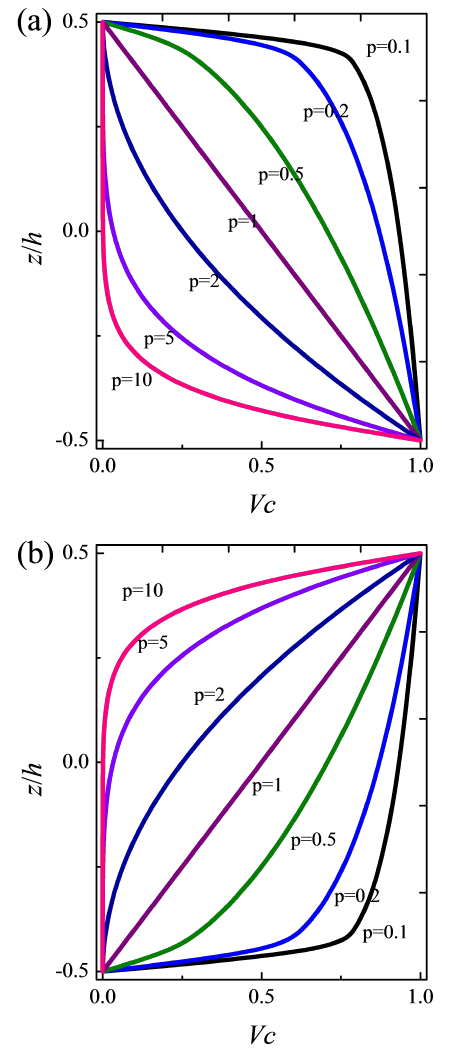
Figure 3: Variation of the ceramic volume fraction V C through the thickness for different values of power-law index p : (a) FGM I distri- bution, (b) FGM II